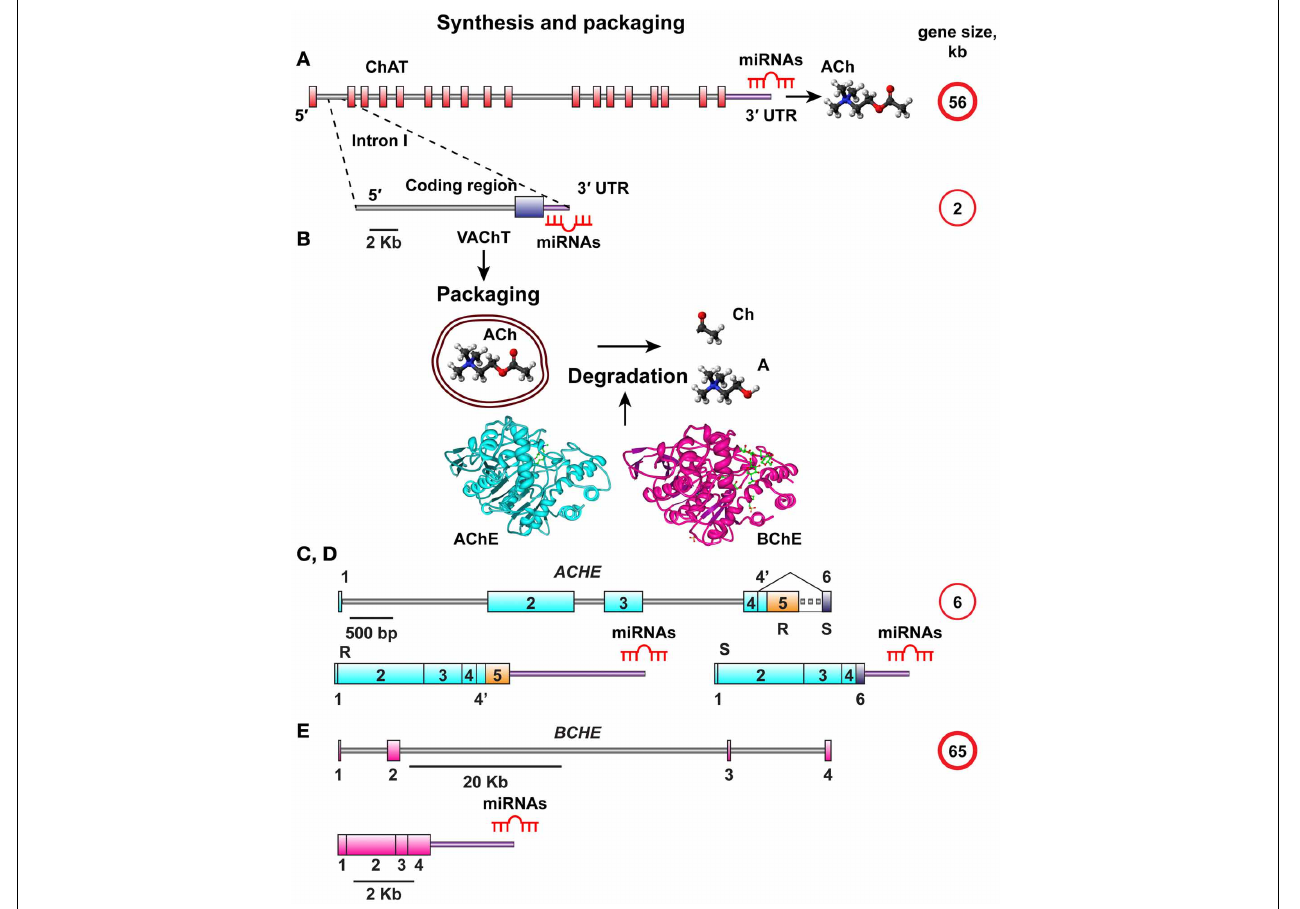
FIGURE 1 | Schematic overview of ACh synthesis, packaging, and destruction. (A) The choline acetyl transferase (ChAT) gene responsible for ACh synthesis is 56kb in size and all its splice variants have the same 3 (cid:2) UTR. (B) The vesicular acetylcholine transporter (VAChT) controlling ACh packaging into vesicles is encoded from the first intron of the ChAT gene. The VAChT gene is only 2kb in length, yet it has its